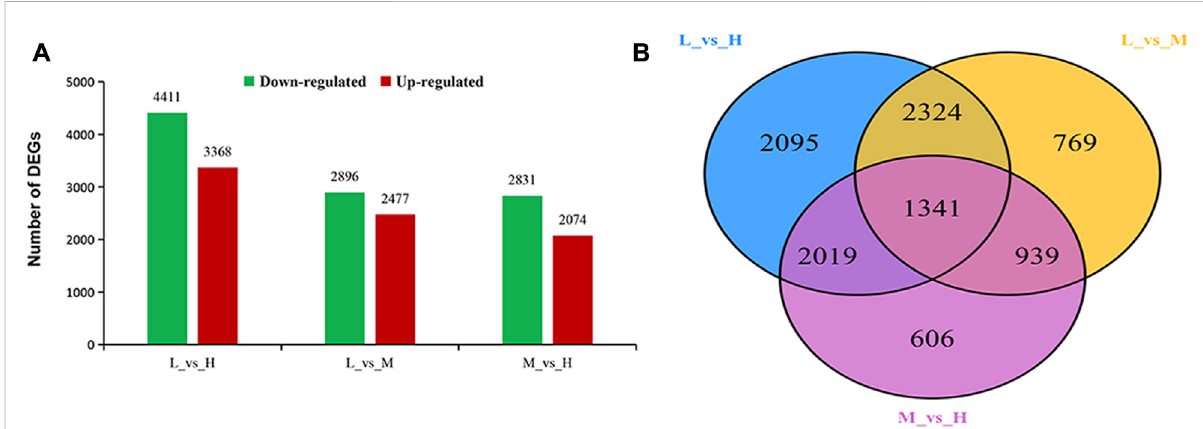
FIGURE 3 Analysis of differentially expressed genes (DEGs) identi fi ed in three experimental comparison groups. (A) Total number of DEGs identi fi ed in each experimental group. Upregulated means DEGs with increased differential expression. Downregulated means DEGs with decreased